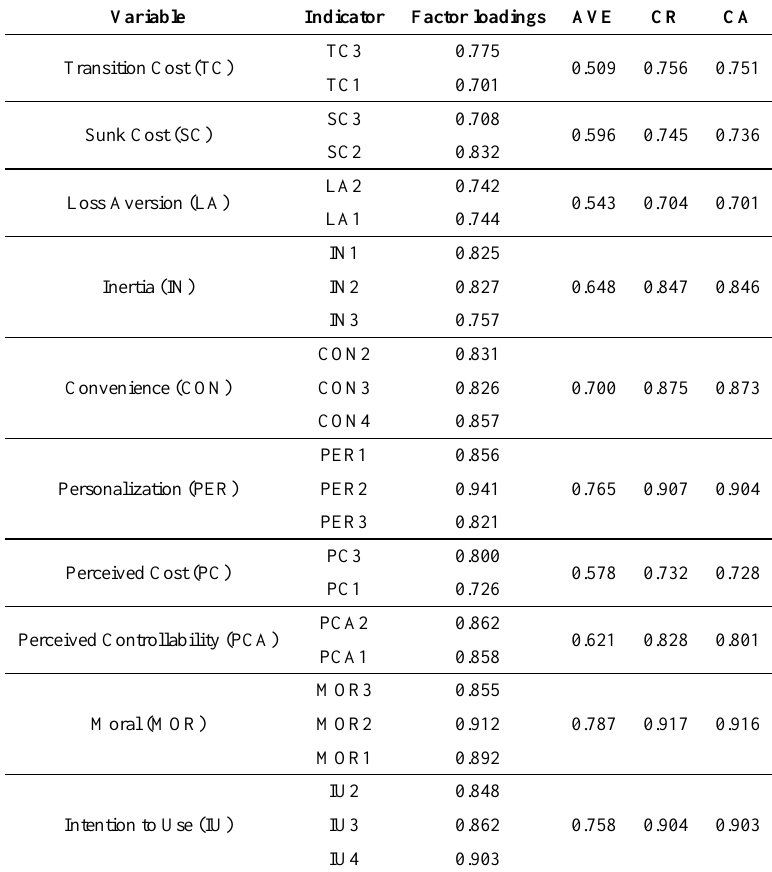
Table 3. Factor loadings, AVE, CR, and